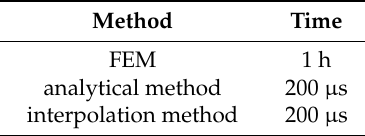
Table 2. Computation time of FEM, interpolation method and analytical